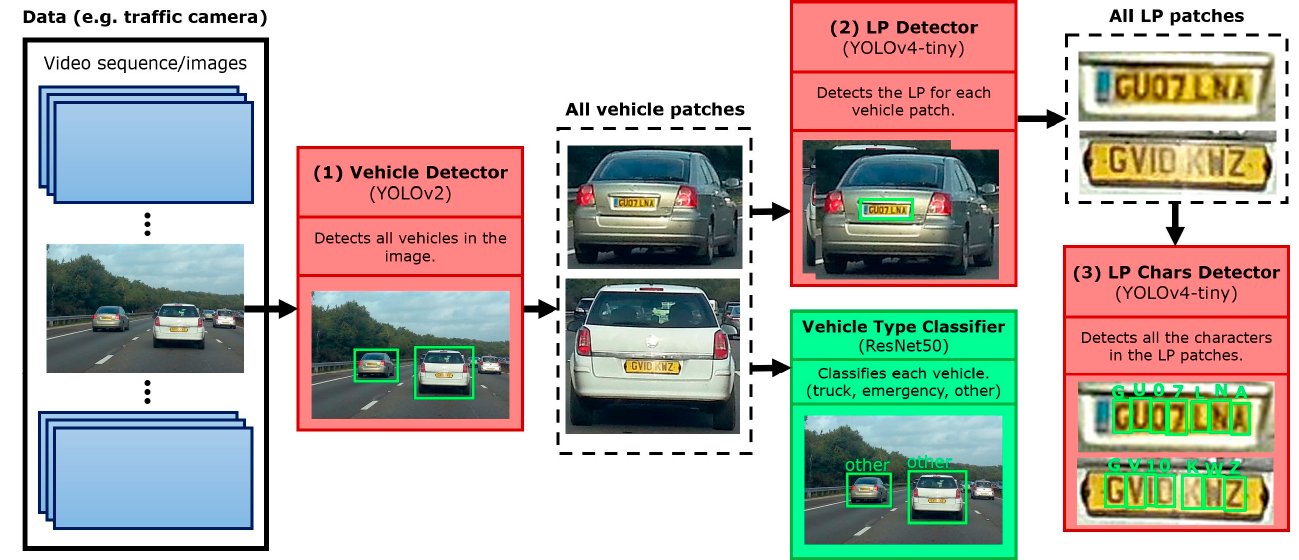
Figure 1. Illustration of the proposed framework.